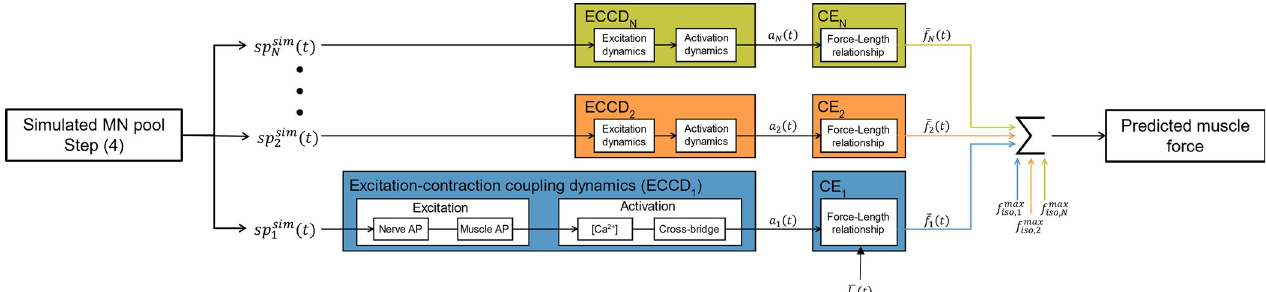
Fig 3. MN-driven neuromuscular model. The N in-parallel Hill-type models take as inputs the N spike trains sp sim predicted whole muscle force trace F sim ð t Þ . The MU-specific active states a j (t) are obtained from the excitation-contraction coupling dynamics adapted from m [98] and extended to model the concentration of the Calcium-troponin system. The MU normalized forces f (CE i ) at MU optimal length and are scaled with values of MU maximum isometric forces f max P force is taken as F sim ð t Þ ¼ ð t Þ f j N j